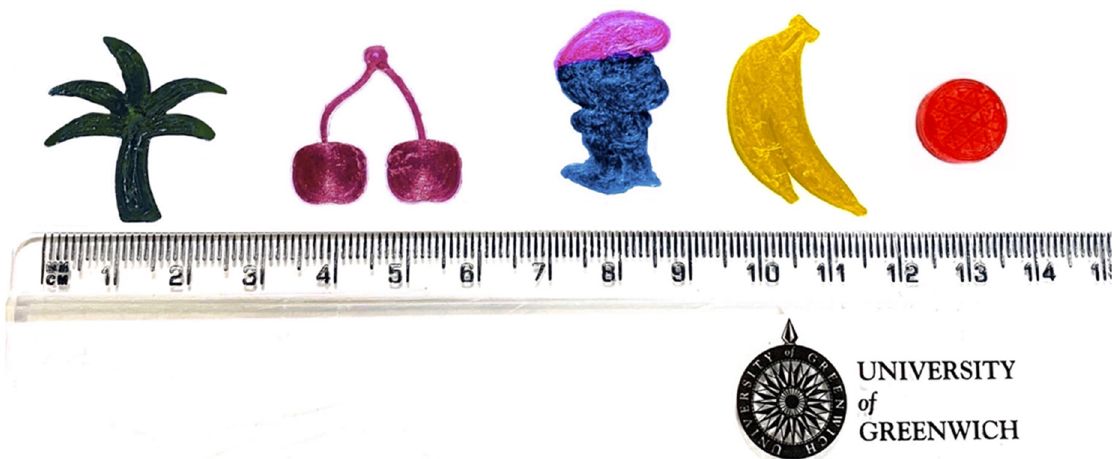
Figure 1. 3D printed fruit chews. from left; palm, cherry, Smurf, banana and tablet.